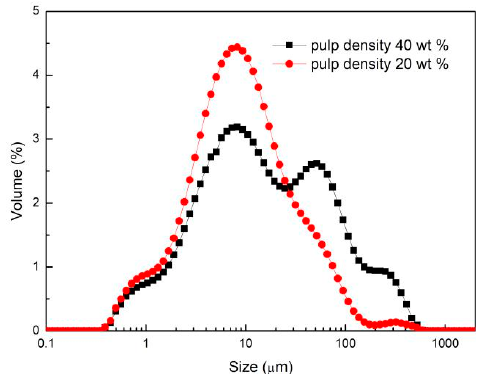
Figure 7 . Particle size distribution of mixture between nickel-copper sulfide and serpentine pulp (1:1) at 40 wt % and 20 wt % densities at pH 9.5.